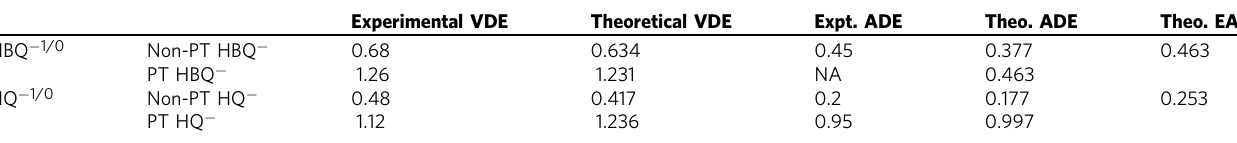
Table 1 Experimental and theoretical vertical detachment energies (VDE) and adiabatic detachment energies (ADE) for non- proton-transferred and proton-transferred 10-hydroxybenzo[h]quinoline anions, non-proton-transferred and proton-transferred 8-hydroxyquinoline anions. Calculated electron af fi nities (EA) for both neutral systems are also presented. All numbers are in